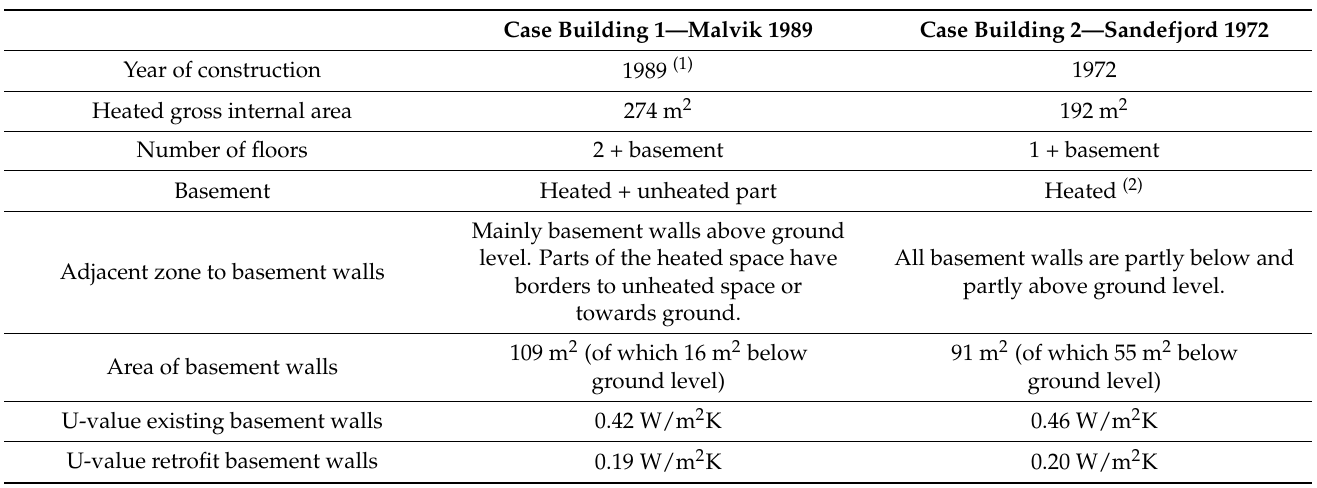
Table 4. Information about the two residential case buildings from OPPTRE.